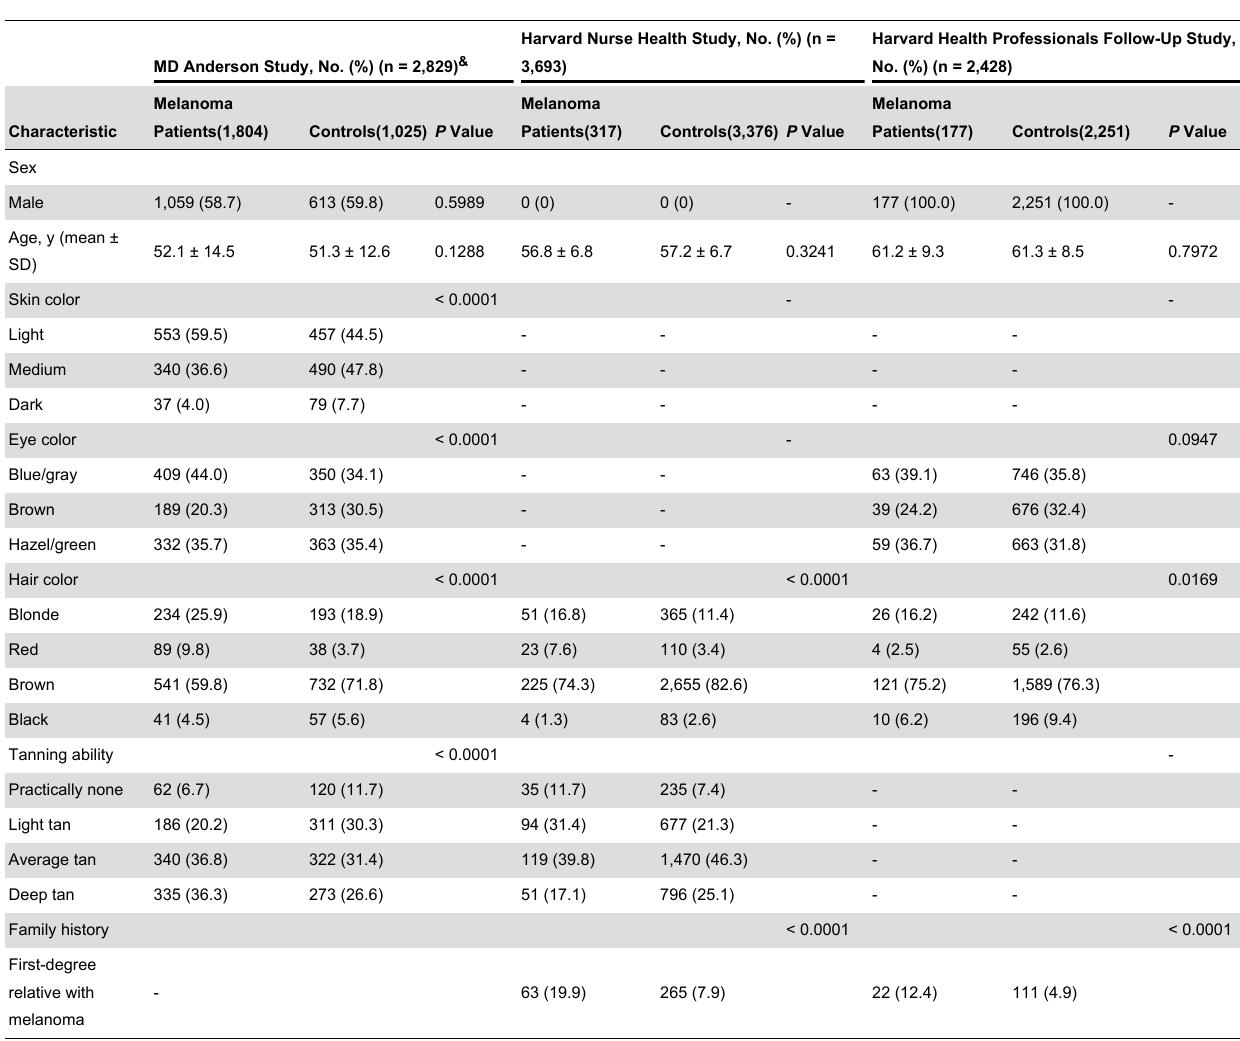
* Data in the table were not available for all patients and controls for pigmentation characteristics and family history in the MDACC and Harvard data sets. & Pigmentation information was collected in 931 patients and 1026 controls via questionnaire. doi: